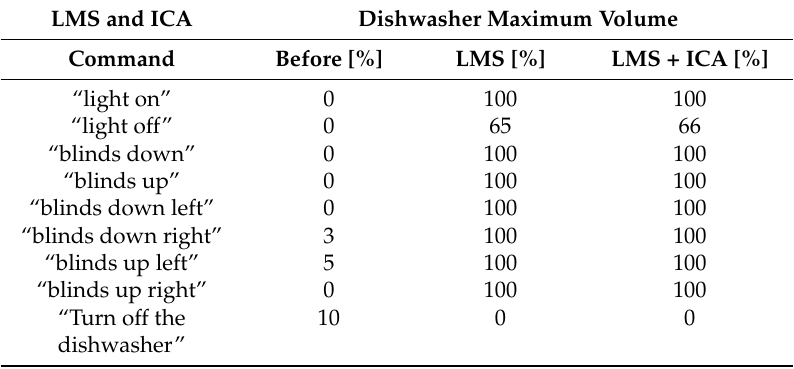
Table 9. The results of recognition success rate for dishwasher